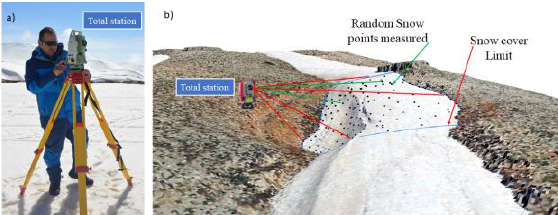
Figure 3: a) Total station; b) random points and survey.